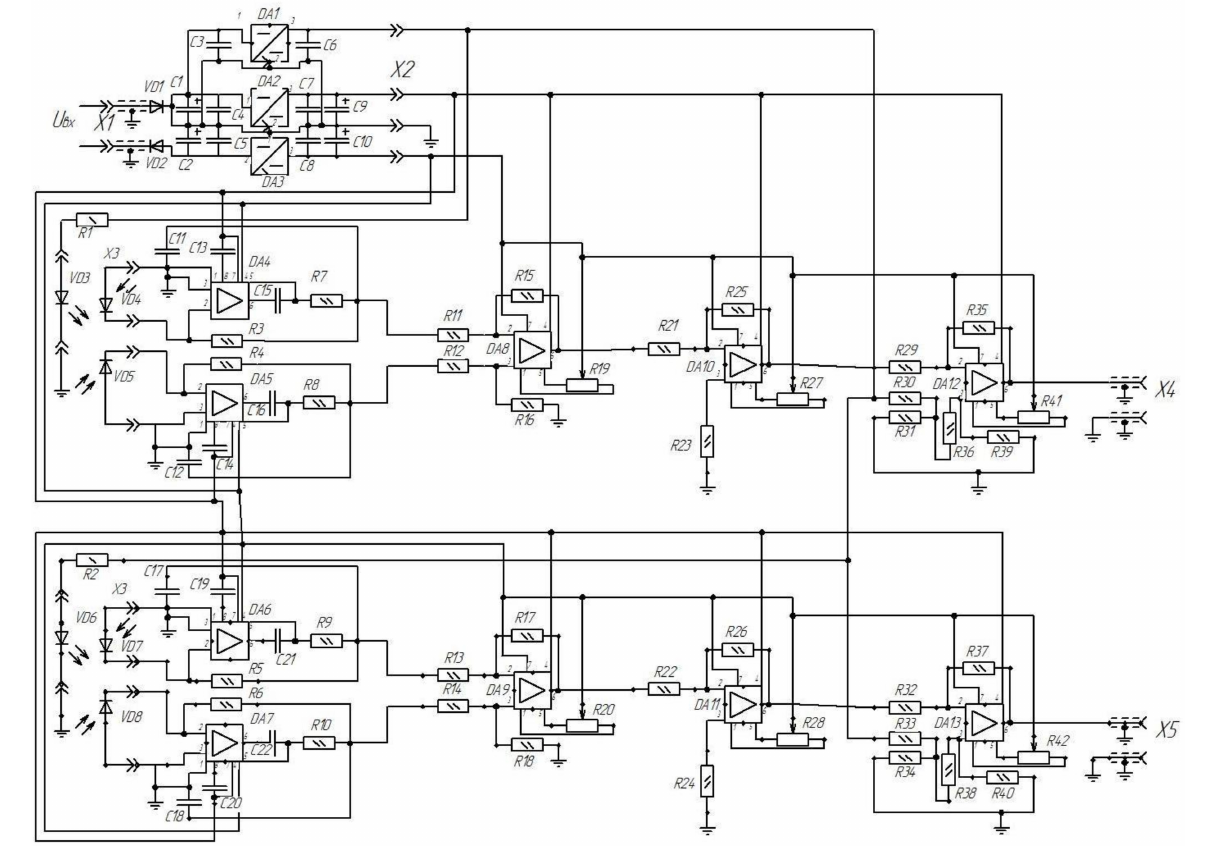
Figure 11. Basic electrical diagram of